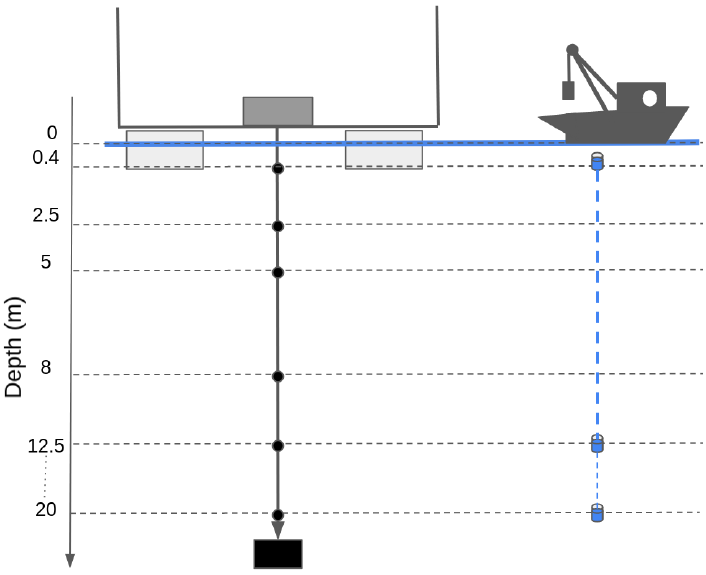
Figure 6. Comparison between AHFM and manual sampling depths.